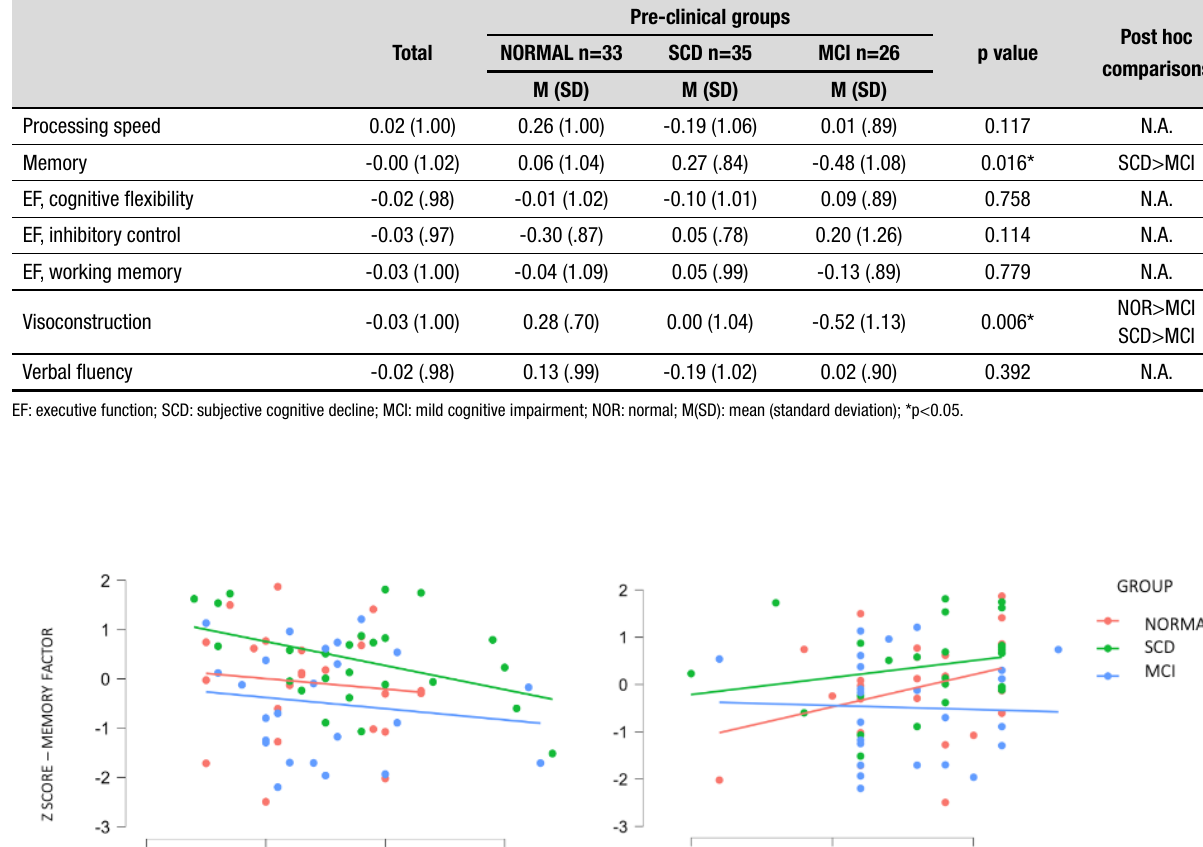
Table 3. ANOVA for comparisons between groups according to components extracted.